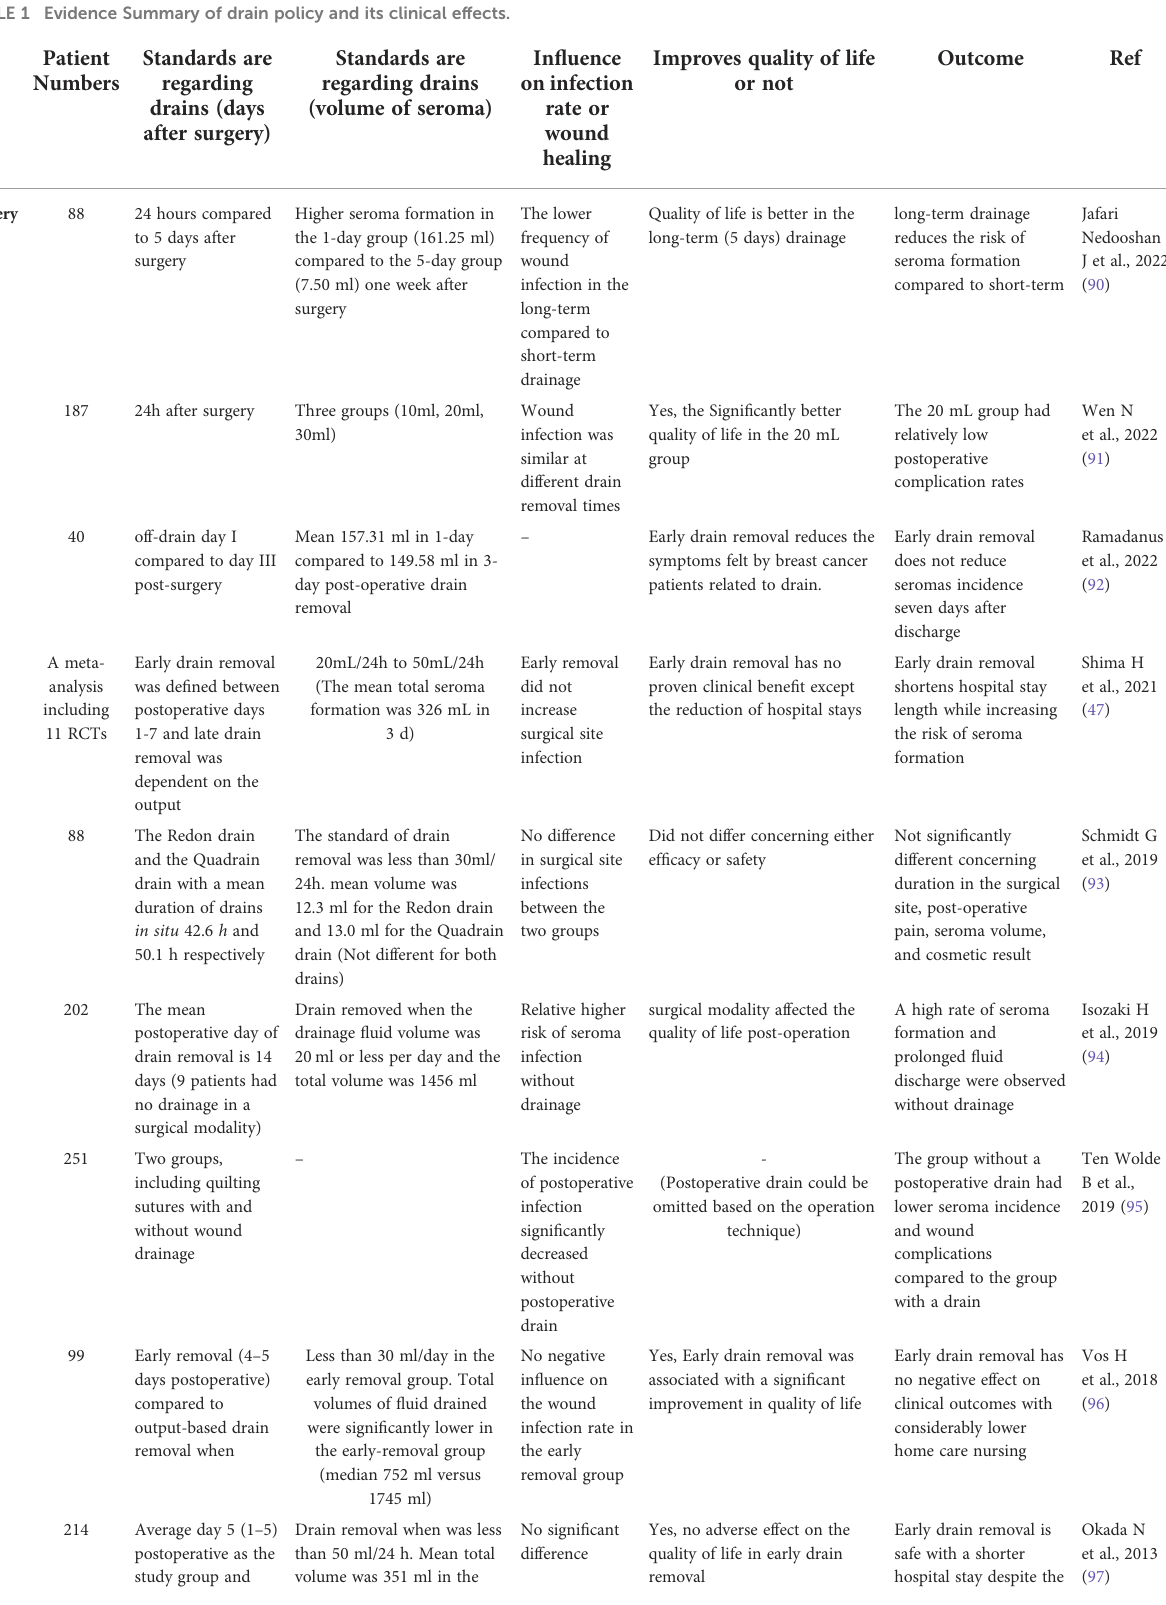
TABLE 1 Evidence Summary of drain policy and its clinical effects. Patient Standards are Numbers